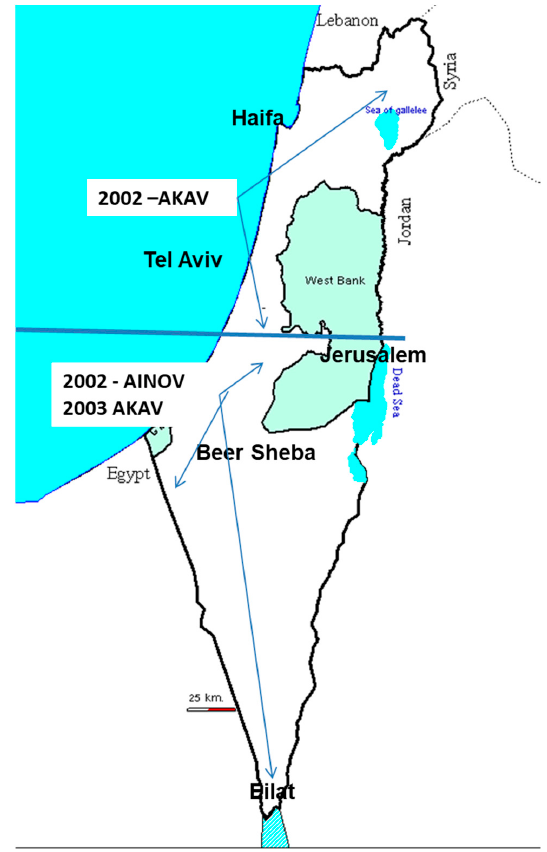
Figure 2. This figure describes the dichotomy of arthrogryposis hydranencephaly syndrome ap- pearances in 2002 due to the Akabane virus attack in 2001 in the northern regions. The sequels of the second attack were observed in 2003 in the southern regions only as the virus spread southward during 2002 (the counter expected direction). AKAV, AINOV: Akabane and Aino virus, respec-